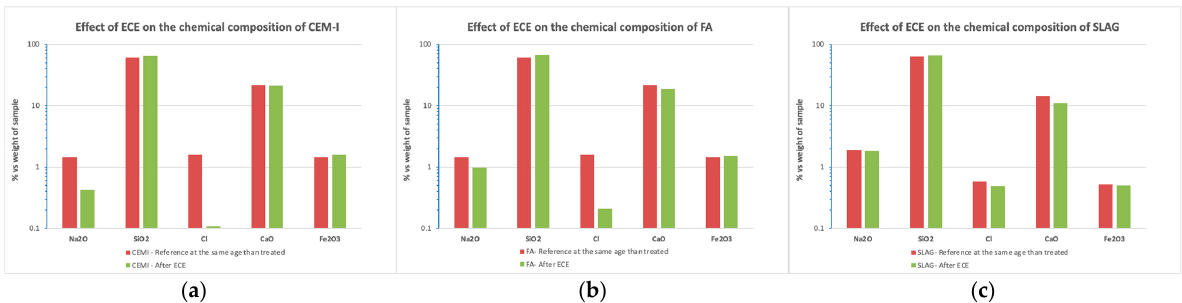
Figure 17. Influence of binder type in the bulk chemical composition before and after ECE treatment. ( a ) CEM I specimens; ( b ) FA specimens; ( c ) SLAG specimens.